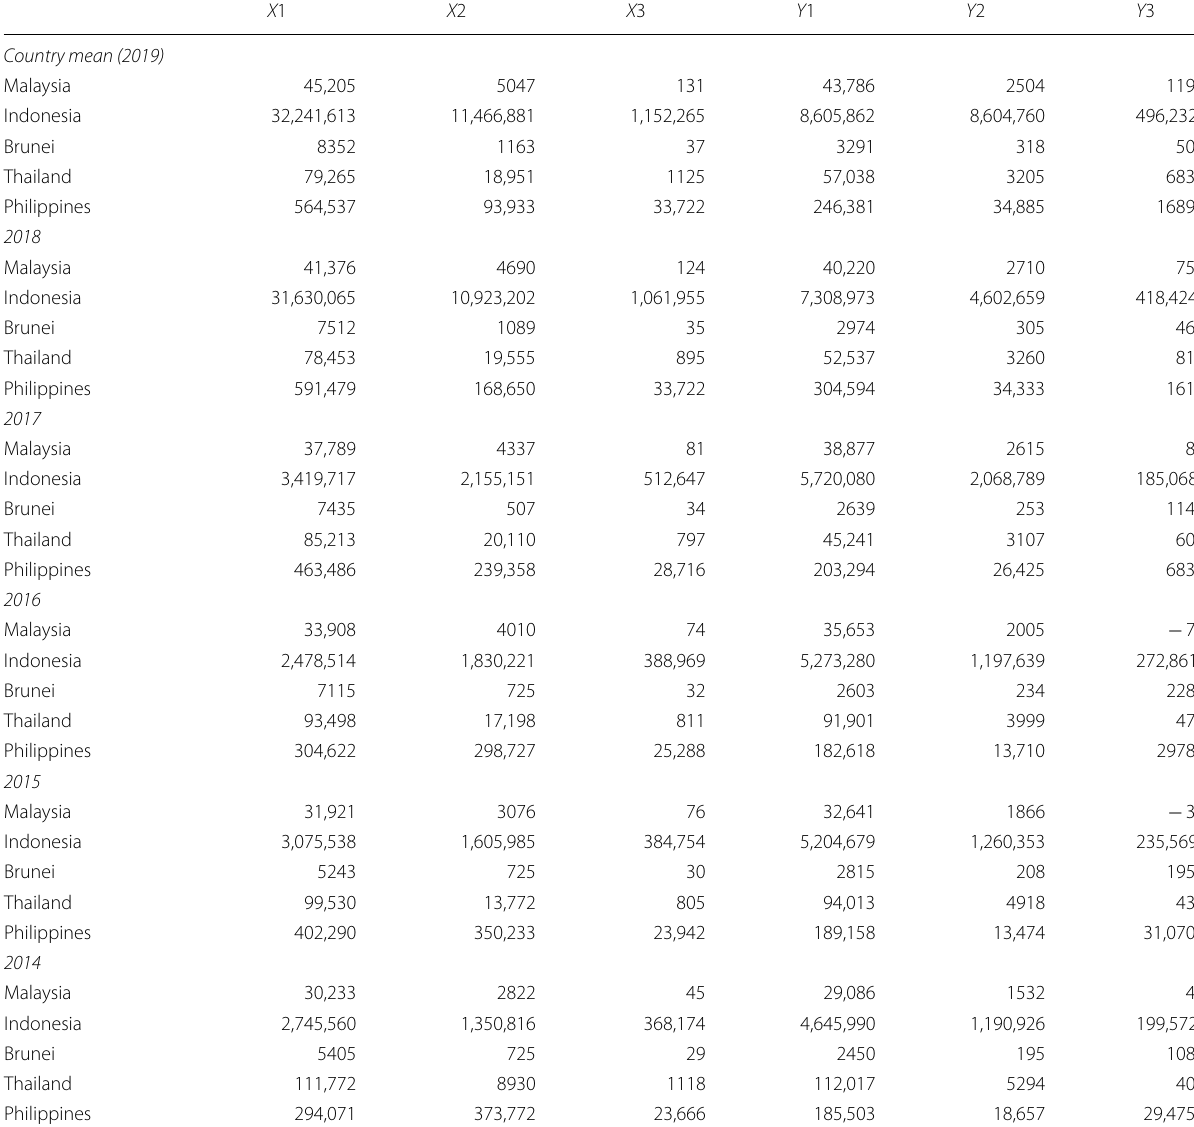
Table 1 Summary statistics of variables in local currency (in